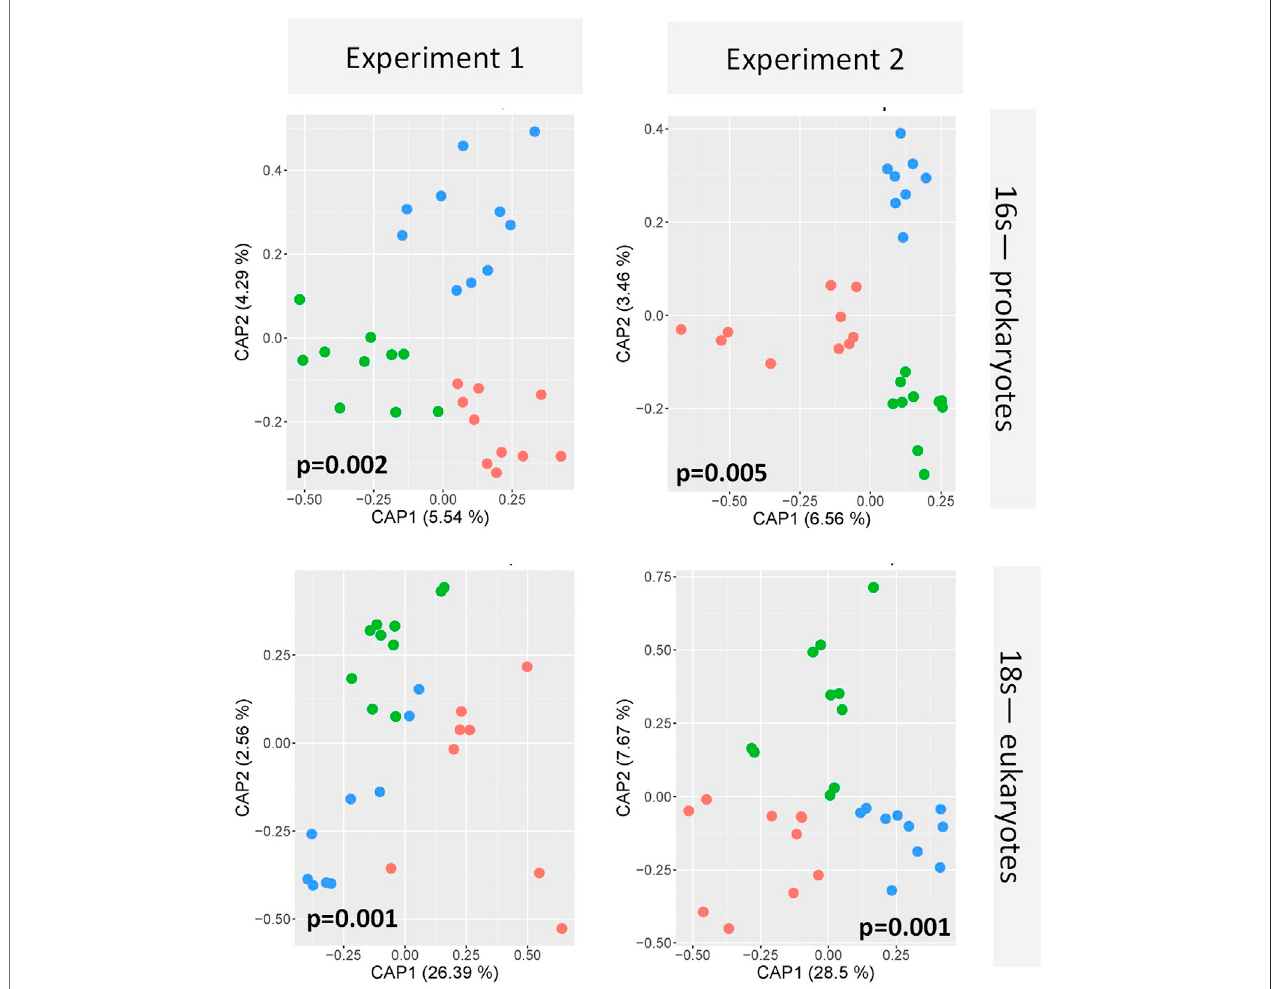
FIGURE4| MicrobialcommunitycompositionofperiphytonresultingfromExperiment1(leftcolumn)andExperiment2(rightcolumn)basedon16S(upperpanels) and 18S ampli fi cation (lower panels) at day 7 of the exposure. Green, red, and blue dots represent control, aged and native MP exposures, respectively. Five independent biological replicates and twotechnicalreplicates per sample were included in theredundancy analysis, which revealsa signi fi canteffect of theexposureon the community composition ( p < 0.05; permutational ANOVA).